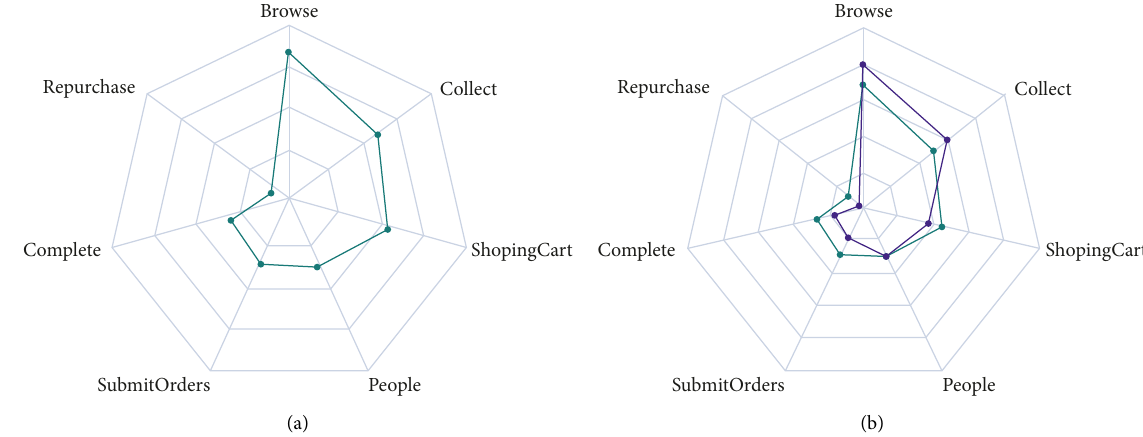
Figure 20: Group user behavior radar map. (a) Group user behavior radar map. (b) Comparison of user behavior among different groups.